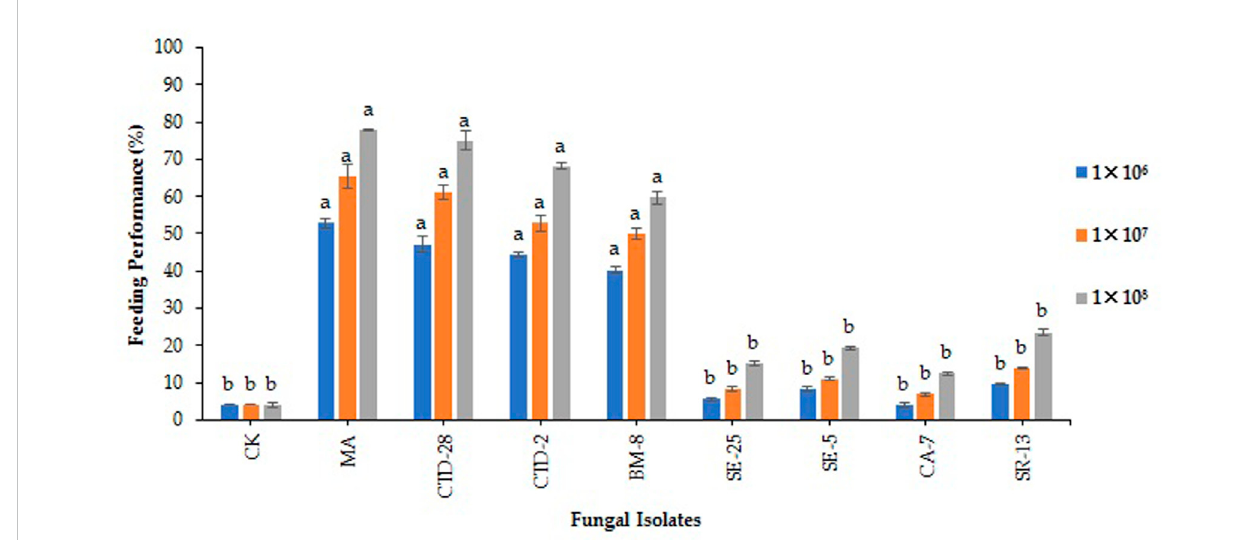
FIGURE 5 Effects of entomopathogenic fungal isolates on the feeding performance of second instar larvae of fall armyworm treated with different concentrations at 48 h post treatment. Error bars denote the mean ± standard error at the 95% con fi dence interval. Means followed by the same letters are not signi fi cantly different by Tukey ’ s test at p < 0.05.